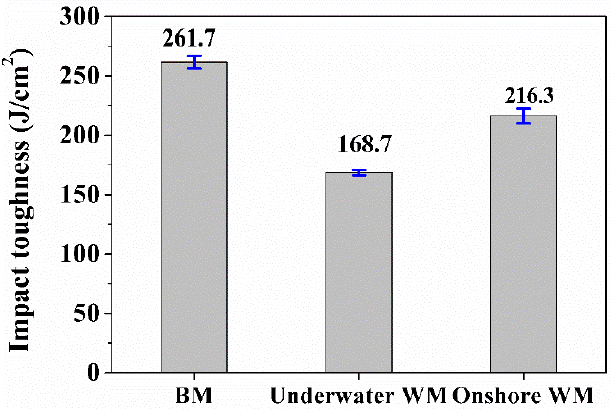
Figure 3. Impact toughness of the BM, underwater weld metal (WM) and onshore WM.